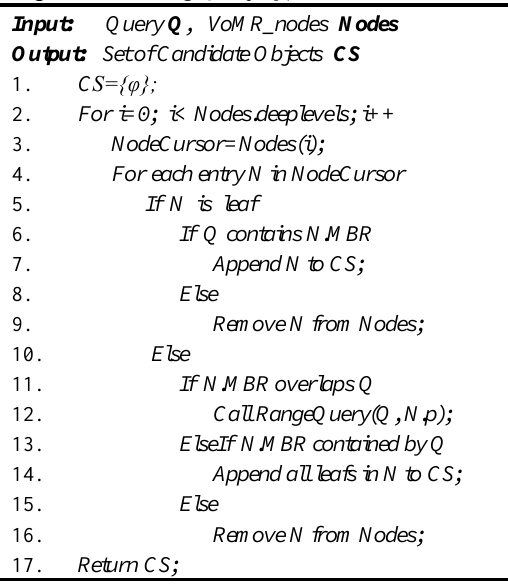
Algorithm 1 . RangeQuery( Q , Nodes )